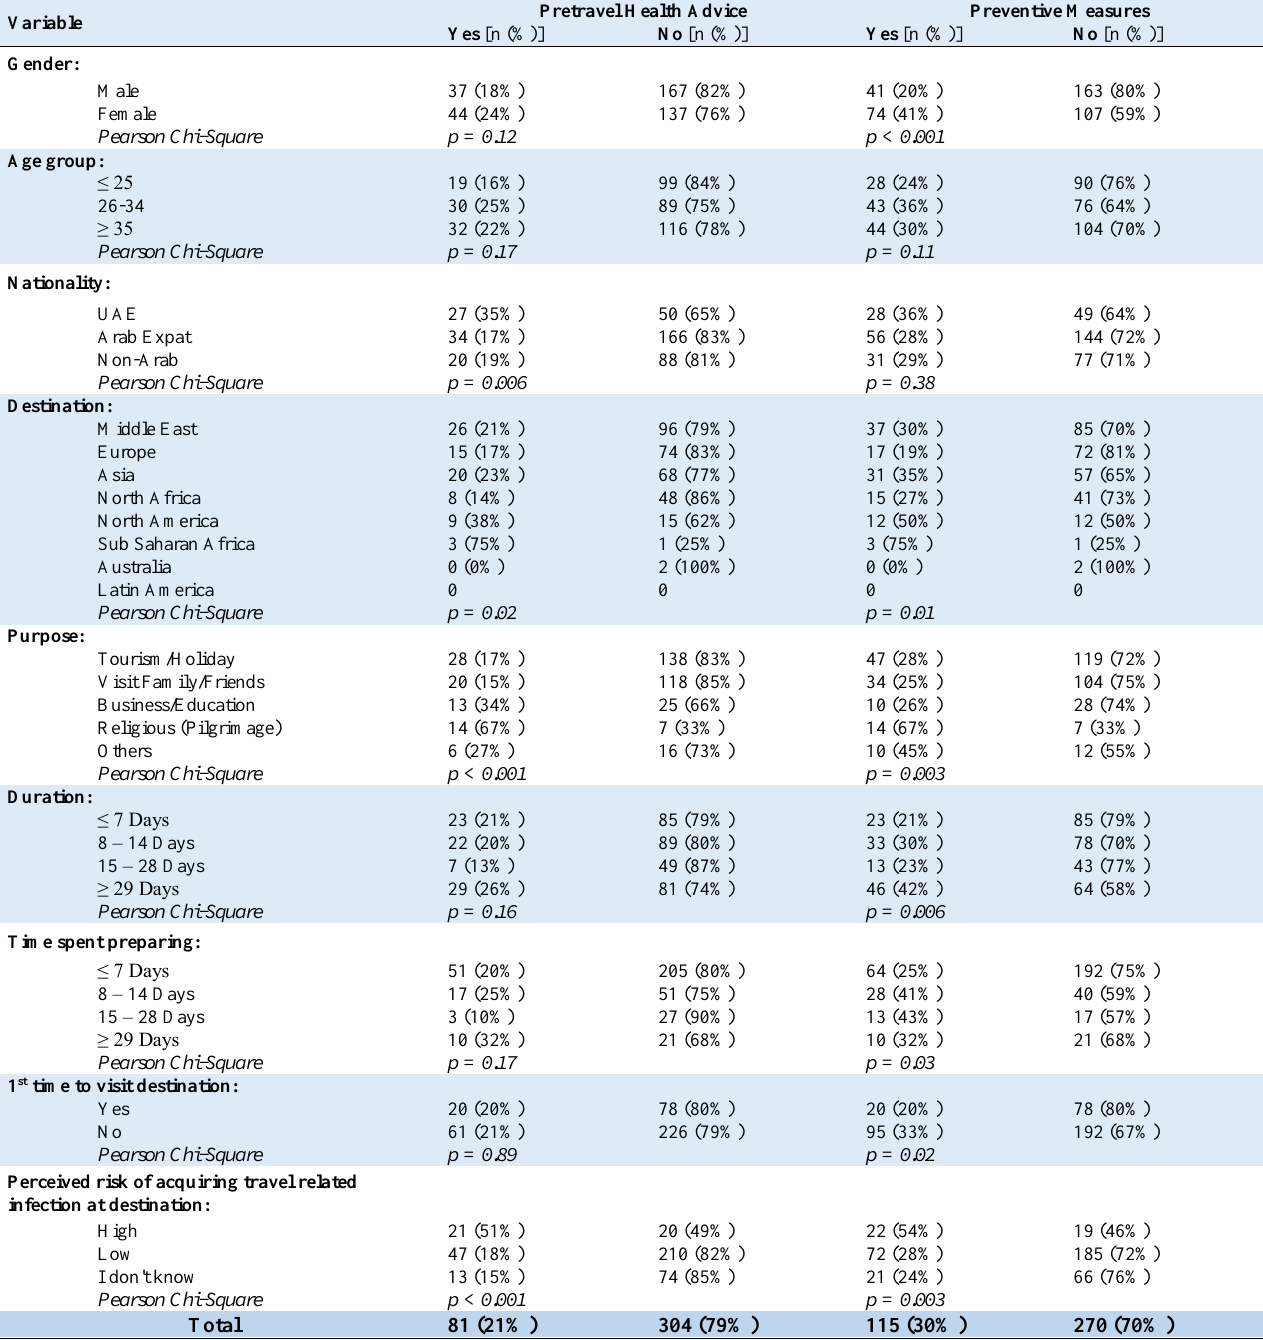
Table 2. Impact of different variables on seeking pretravel health advice and acquiring preventive measures. A Pearson Chi-Square is presented for each variable. A p value less than 0.05 was considered to be statistically significant Pretravel Health Variable